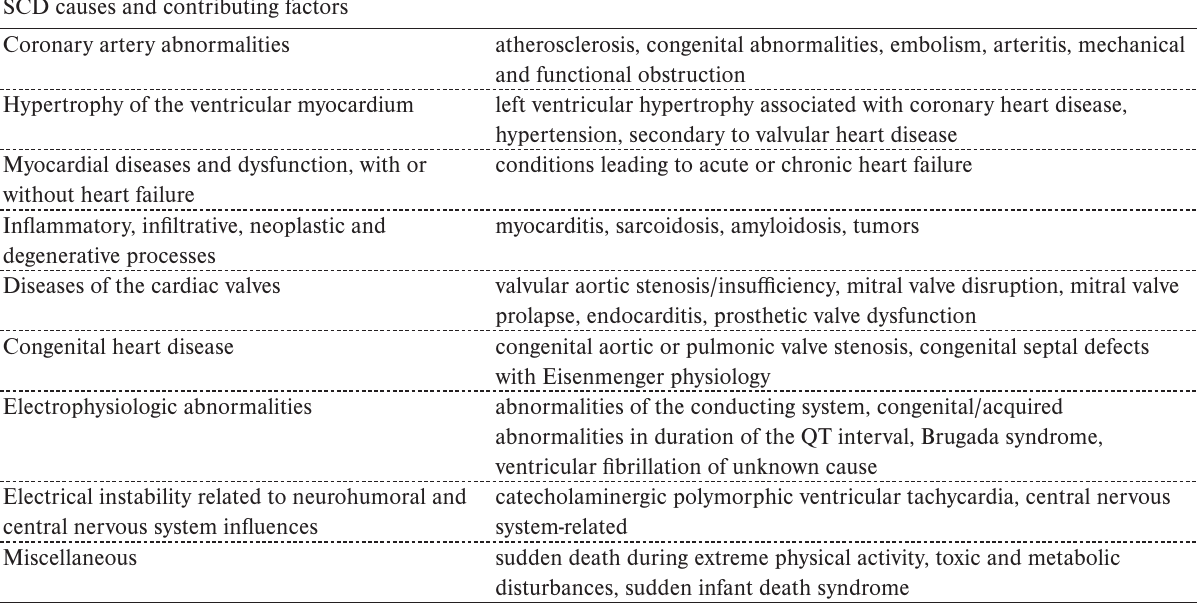
Table 1. SCD causes and contributing factors (adapted from Myerburg 2018 (ref. 1 )) SCD causes and contributing factors atherosclerosis, congenital abnormalities, embolism, arteritis, mechanical and functional